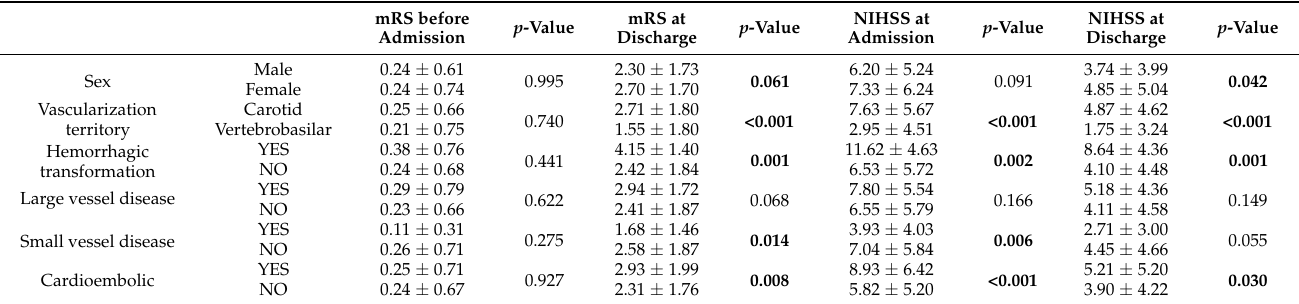
Table 5. ANOVA prognosis data.